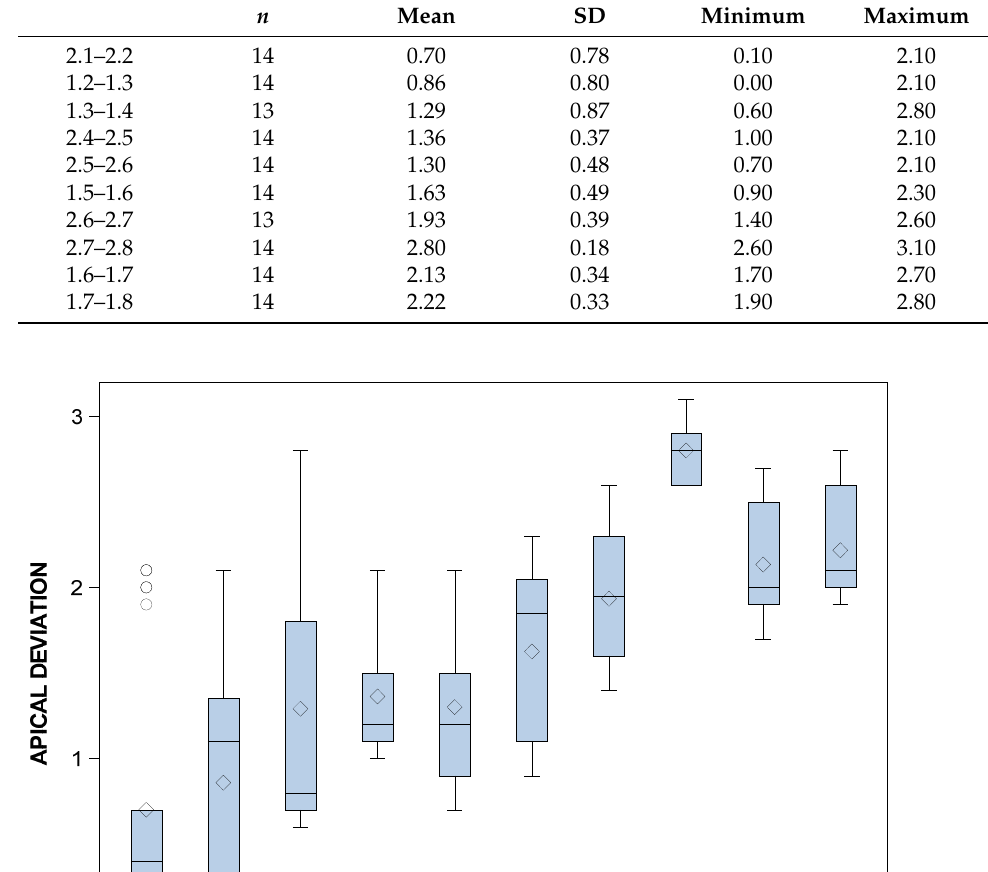
Table 5. Descriptive deviation values at apical end-point (mm) of the orthodontic micro-screws placed in the selected tooth positioning.